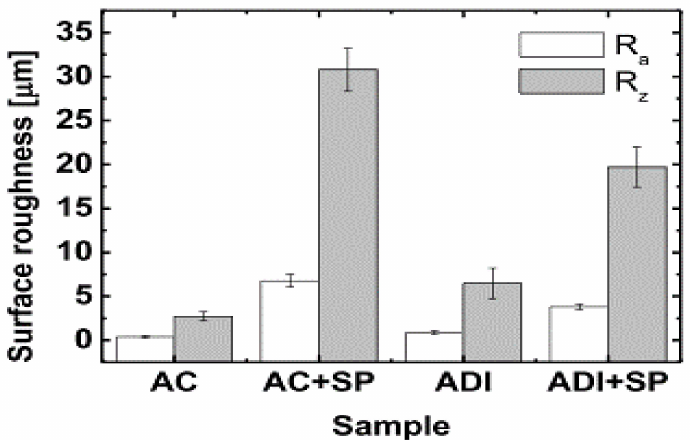
Figure 35. Microhardness variables obtained during shot peening on cast and ADI samples [51].